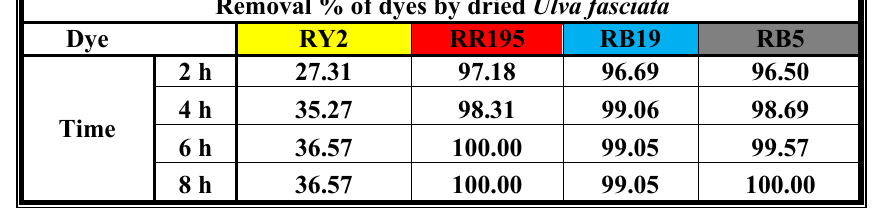
Fig. 14 Effect of contact time (at optimized conditions) on the removal percentages of the four studied dyes by dried Ulva fasciata